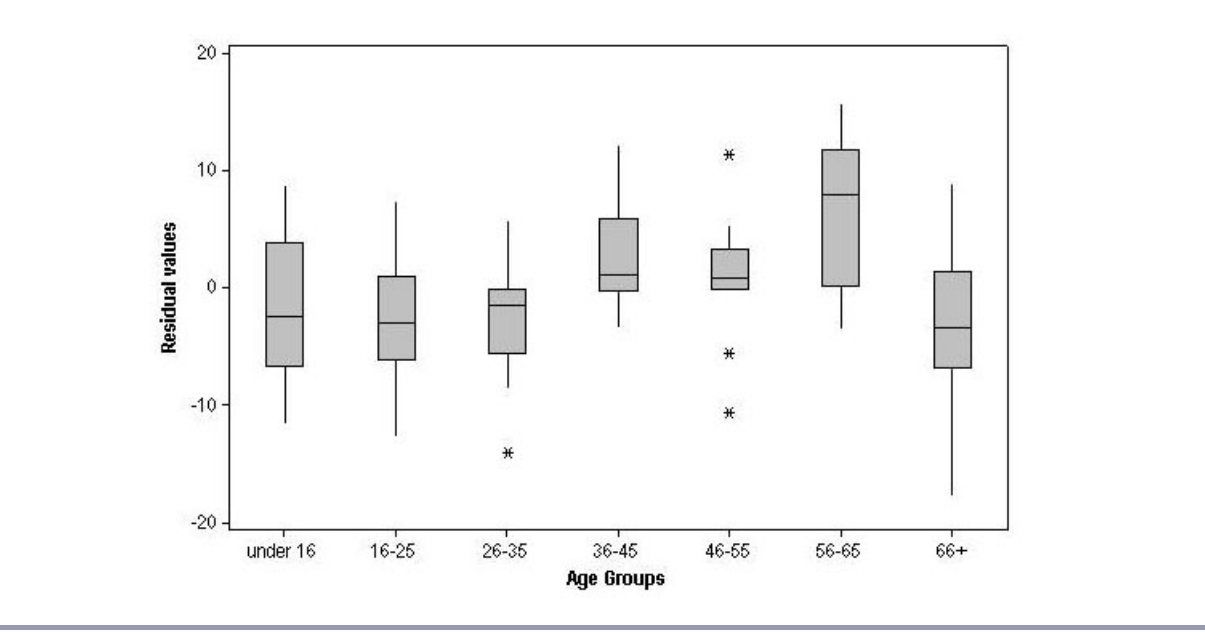
Fig. 2 . Residuals of age groups for the 25 th percentiles of distance